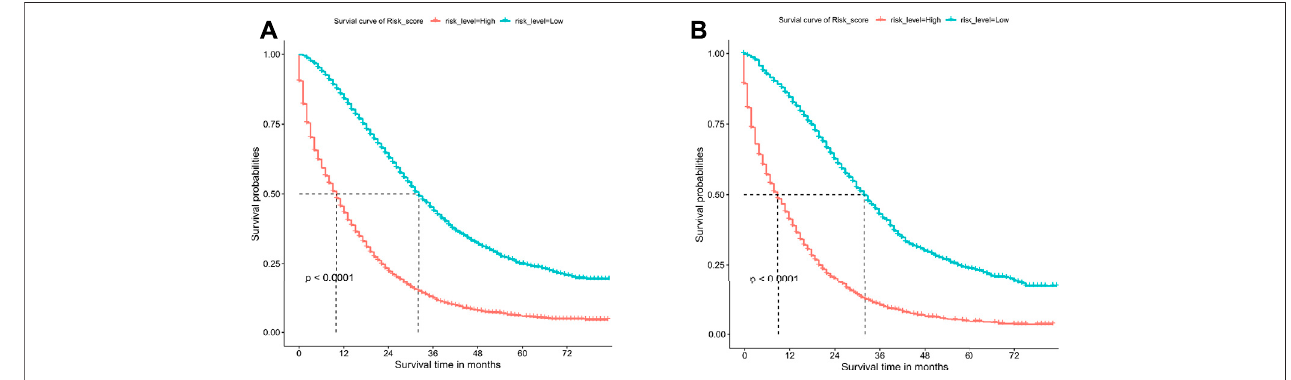
FIGURE 7 | Overall survival (OS) Kaplan-Meier curves for patients in the low- and high-risk groups. (A) training cohort. (B) internal validation